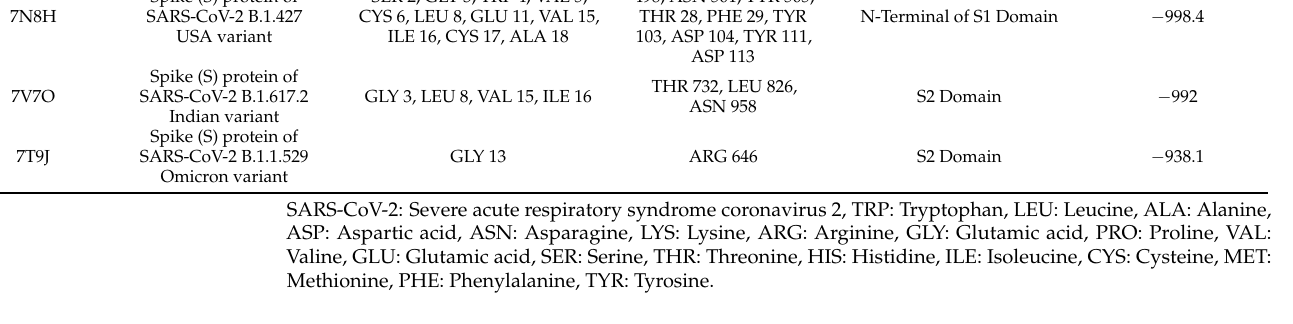
Table 8. Molecular docking analysis of surfactin (PDB ID: 1JMK) derived from B. subtilis